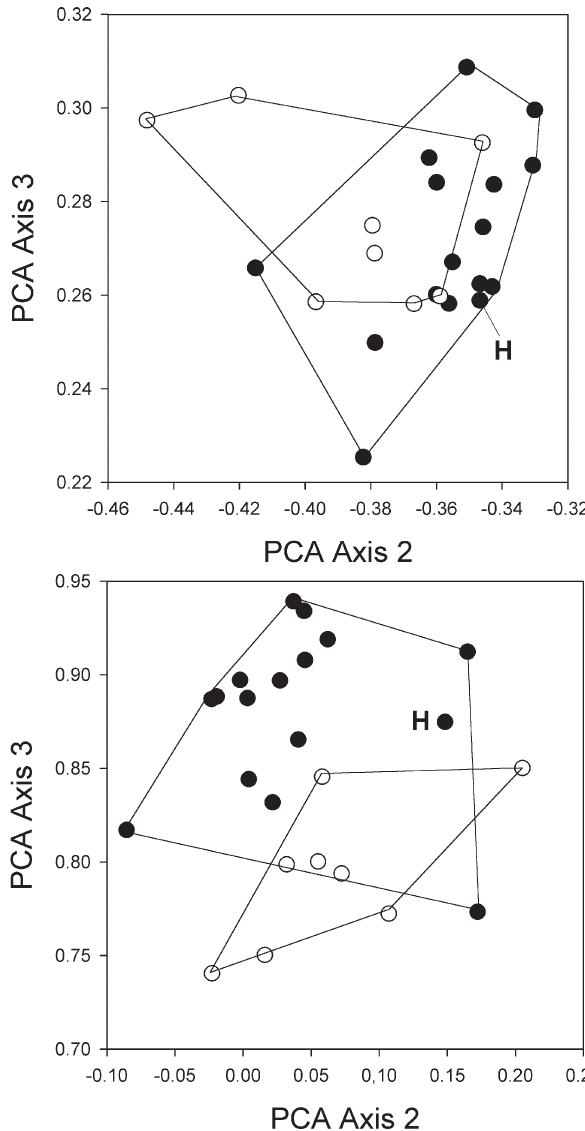
Fig. 2. Plots of factor scores of principal component analysis of Isbrueckerichthys alipionis . Above: head measurements only; Below: all measurements. Dot: epigean population; circle: hypogean population. H =